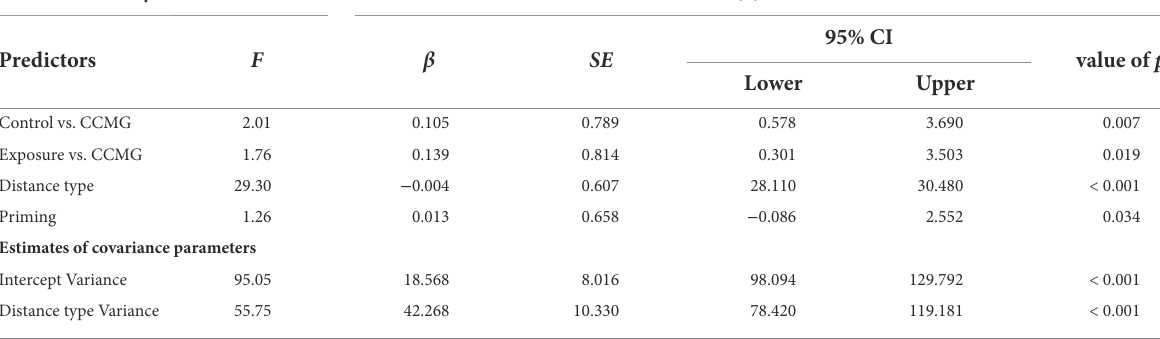
TABLE 4 Summary of linear mixed model analyses for the predictors game, distance type and priming. Model